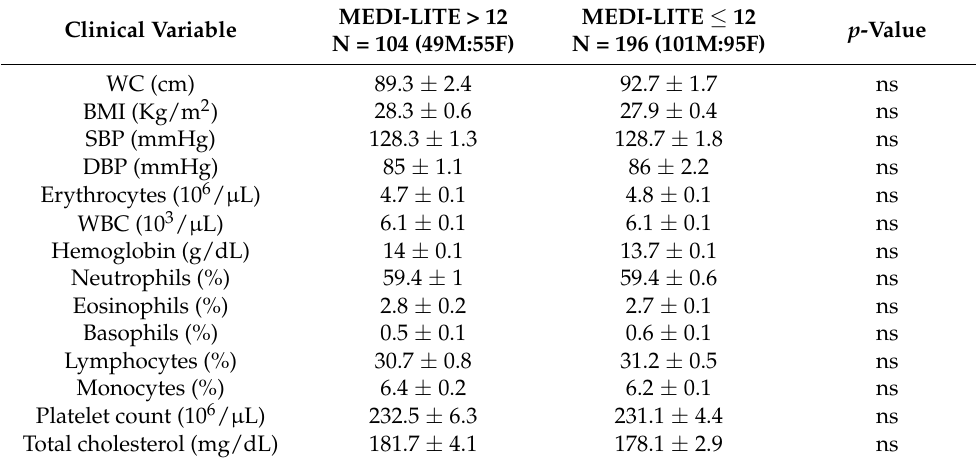
Table 3. Comparison of subgroups identified according to MEDI-LITE above and under the ROC- identified cut-off of 12 for visceral obesity assessed as increased waist